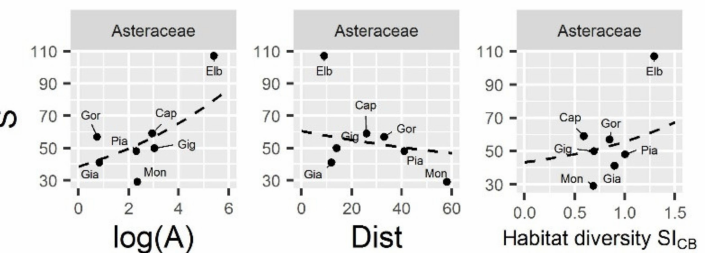
Figure 6. Equilibrium Hypothesis combined with Habitat Diversity Hypothesis (EQH + HDH) according to the Logarithmic function: Joint effect of logarithm of island area (log(A)) and distance (D) and effect of habitat diversity (SI CB : Shannon’s Index on CORINE Biotopes) on the species richness (S) of Asteraceae in the Tuscan